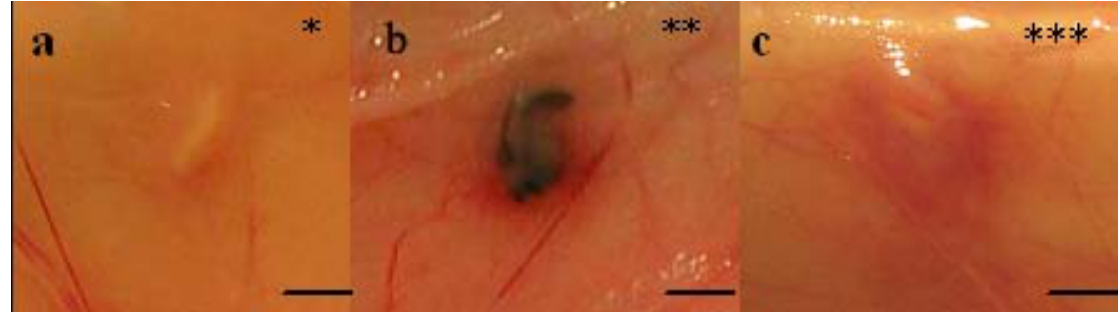
Figure 2. In vivo macroscopic appearances (graded * to ***) of implants at explantation. The rating in Table 2 is exemplified by (A) 4RepCT, degree* (C3 from animal no 1), (B) Mersilk TM , degree ** (from animal no 3), and (C) 4RepCT, degree*** (C3M from animal no 1). Scale bars are 1.0 cm.